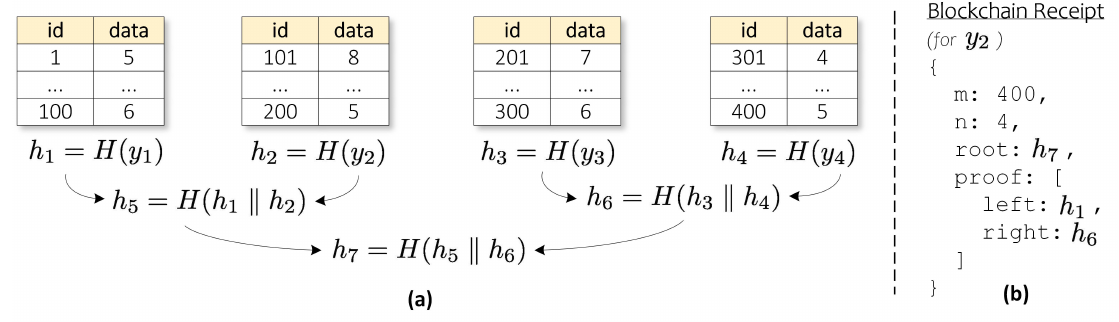
Figure 6. ( a ) A scenario for constructing a Merkle Root, h 7 , from a table containing 400 rows of IoT raw data ( m = 400) split into 4 sub-tables ( n = 4): From this structure, we can build blockchain receipts for each of the sub-tables. ( b ) The receipt for y 2